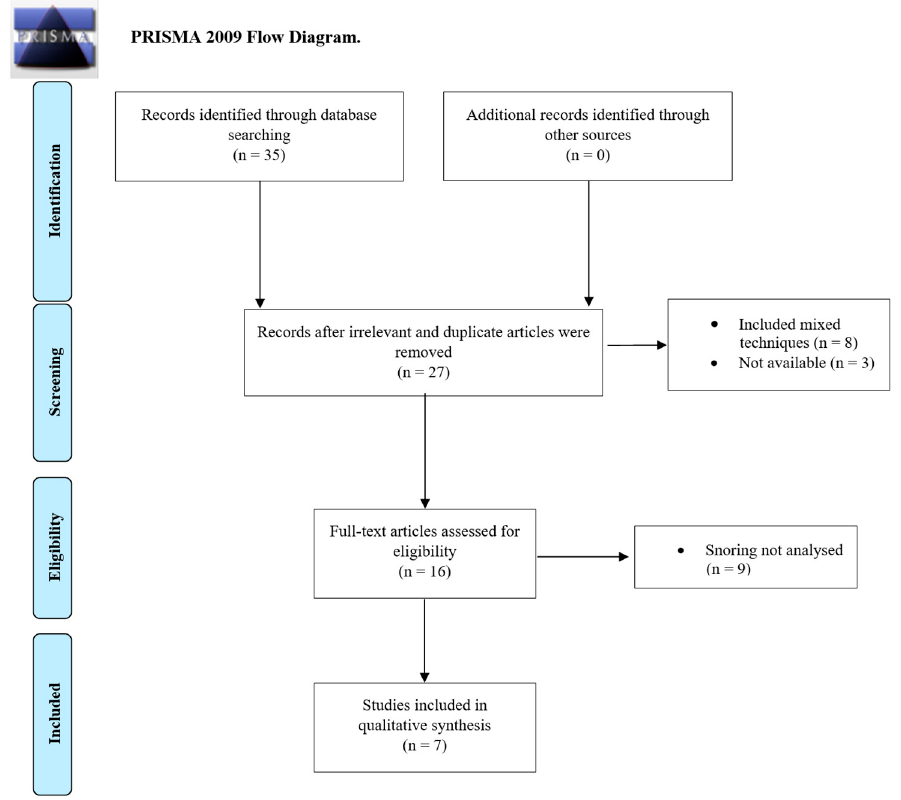
Figure 1. Flowchart of the paper selection process (based on PRISMA guidelines).